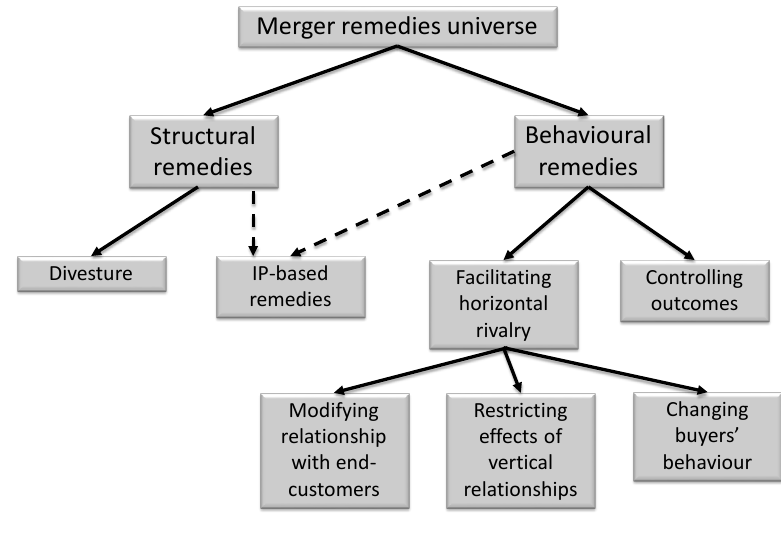
FIGURE 1: Types of merger remedy Source: ICN,